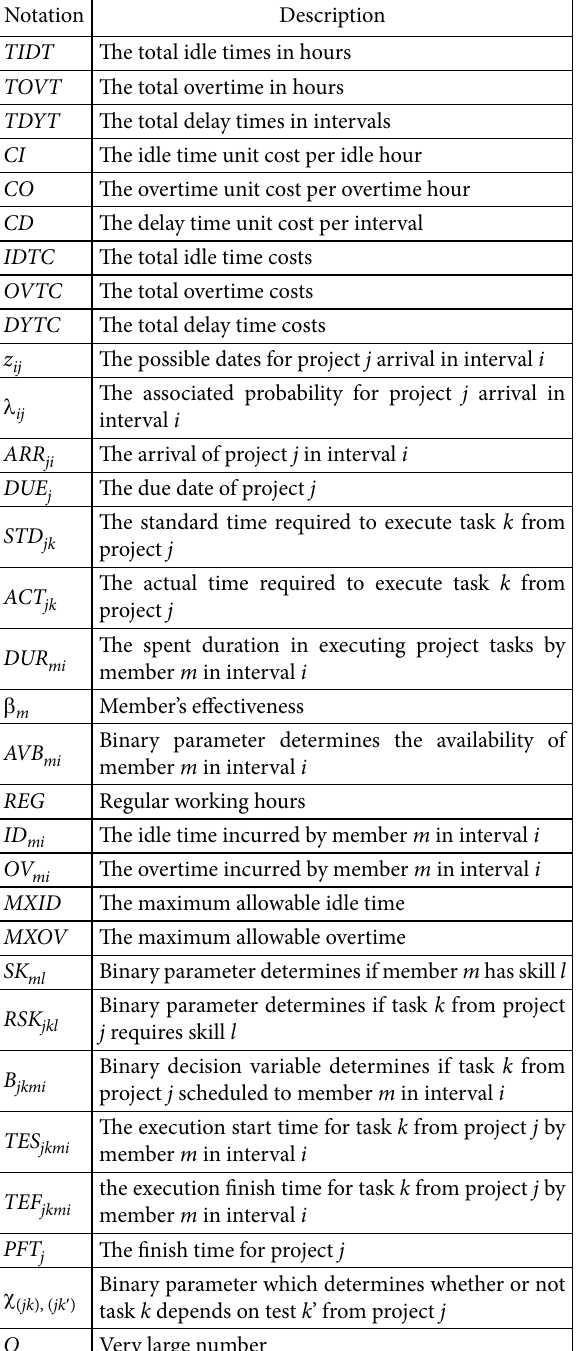
Table 1. Model’s